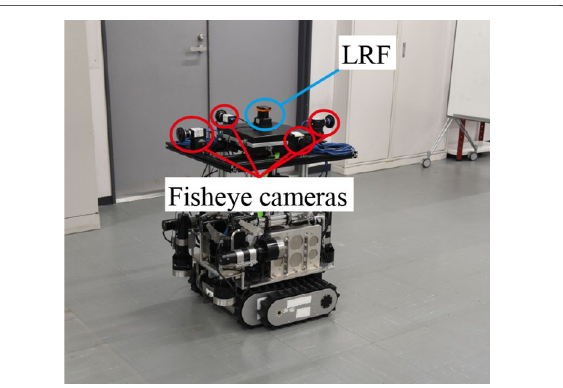
Fig. 8 Experimental setting. Four fisheye cameras and one LRF are mounted on the